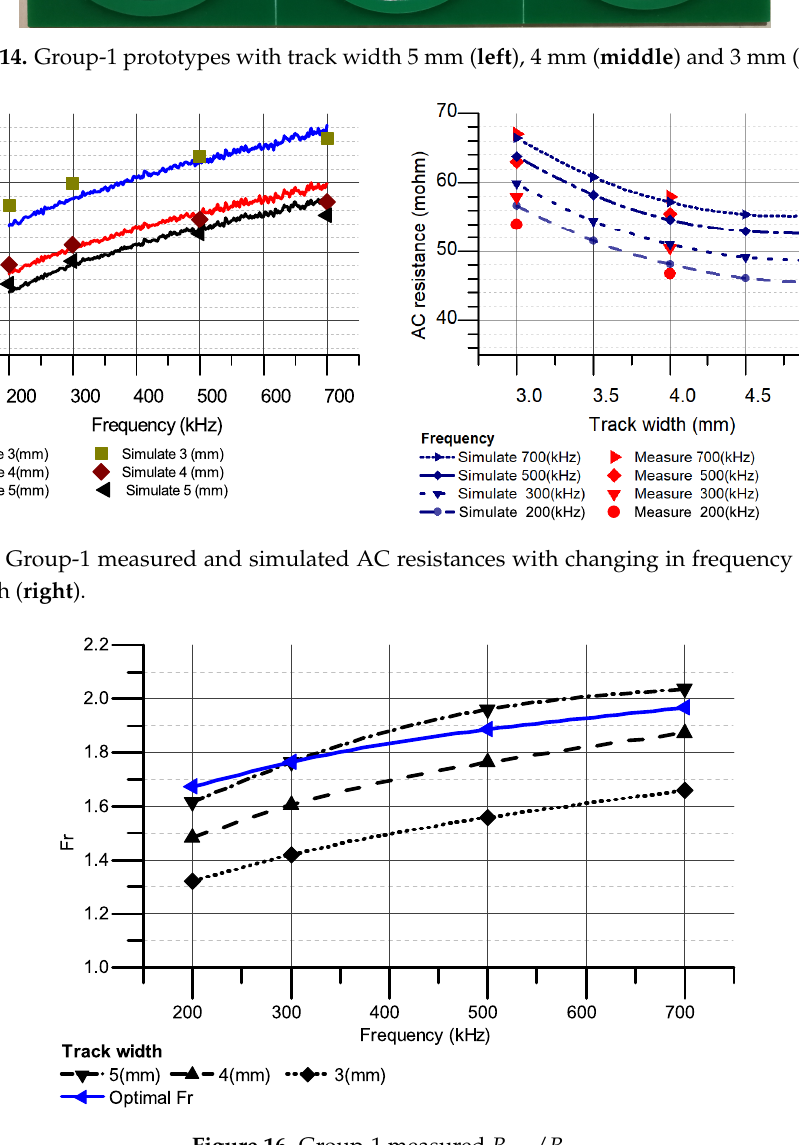
Figure 16. Group-1 measured R AC / R DC